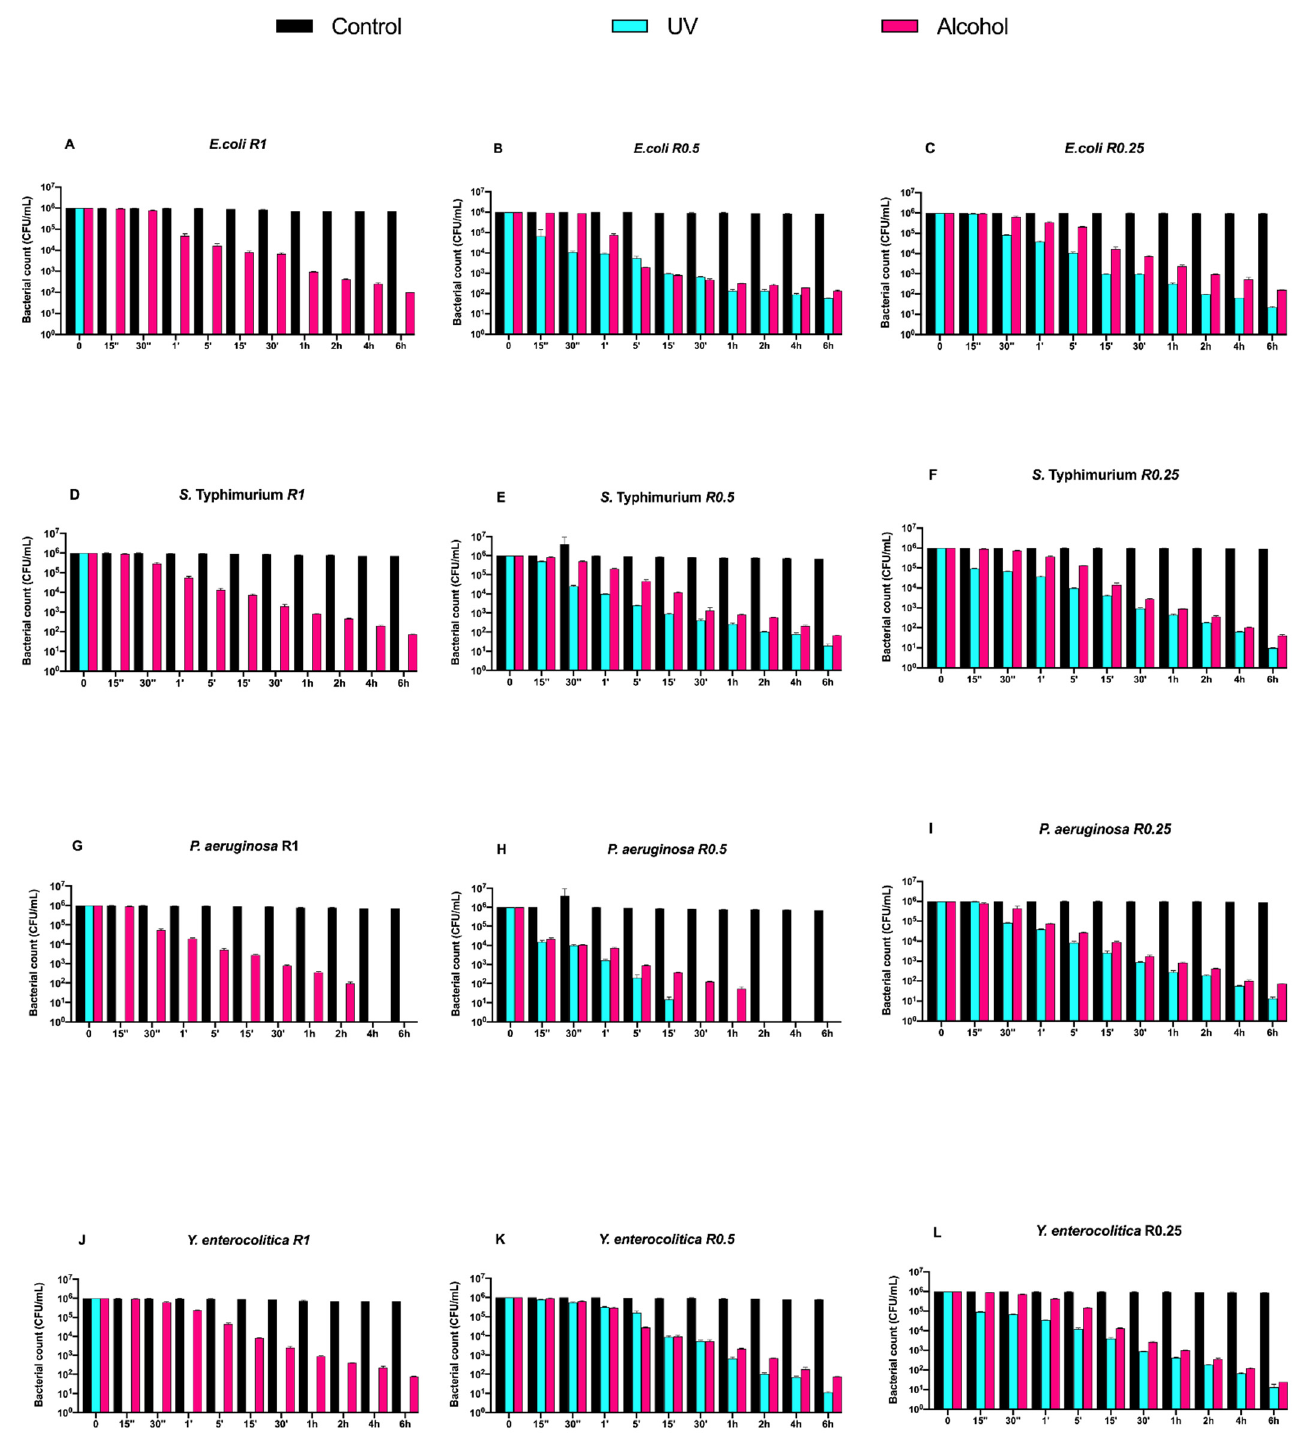
Figure 4. Graphical representation of Gram-negative bacterial counts (A-L) at different exposure times on uncoated aluminum disks with different surface roughness (R0.25, R0.5 and R1 μ m) and subjected to UV and alcohol sanitizing methods.